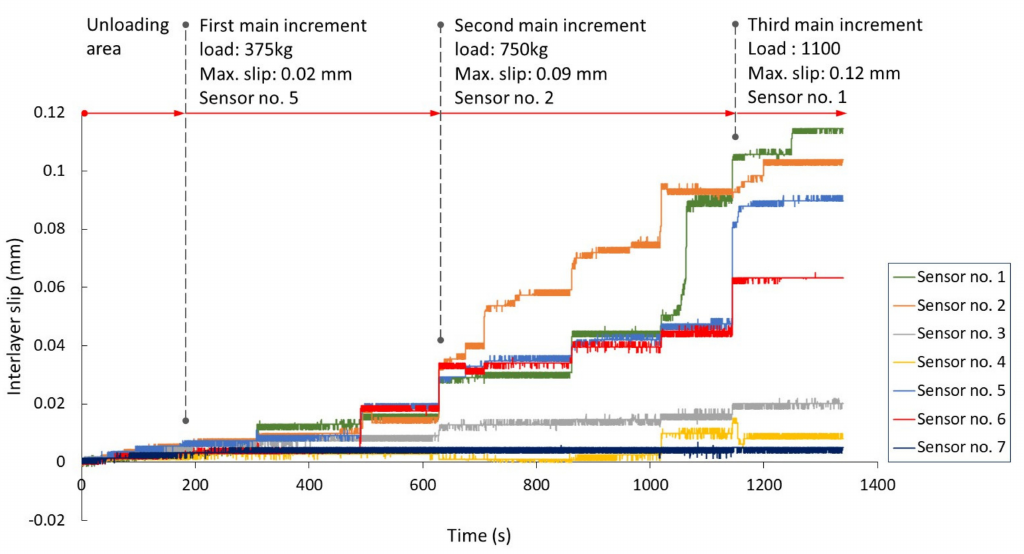
Figure 9. The interlayer slip of composite beam without damage under loading.